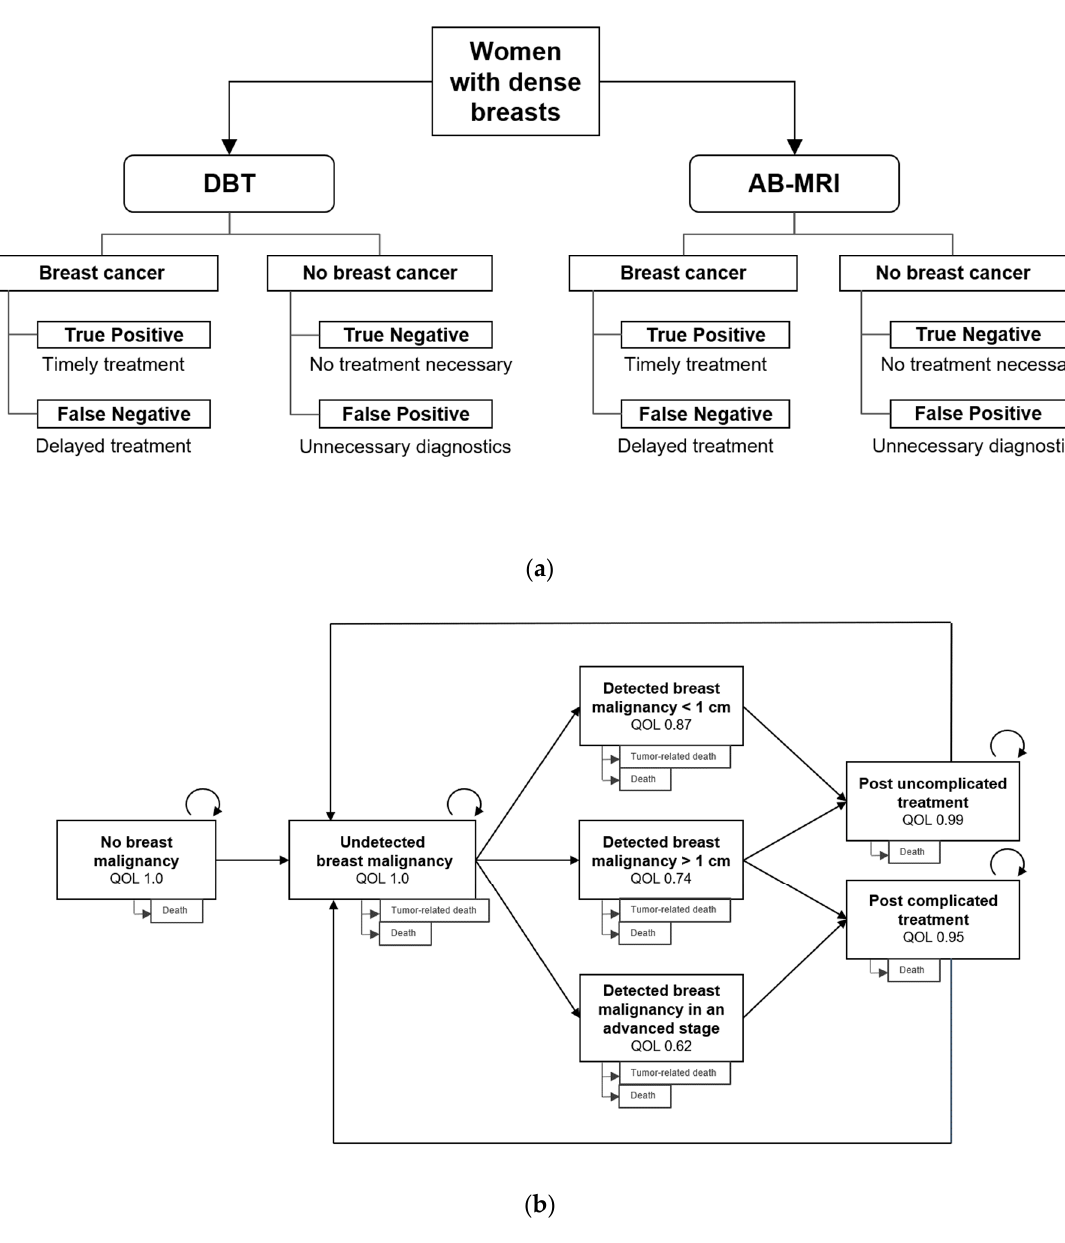
Figure 5. ( a ): Decision ‐ tree including both screening strategies and the corresponding outcomes. ( b ): Markov Model: Probability of breast malignancy detection depends on the sensitivity of the screening modality and the time since development of the disease. Corresponding quality of life (QOL) for the Markov states is indicated in the boxes.